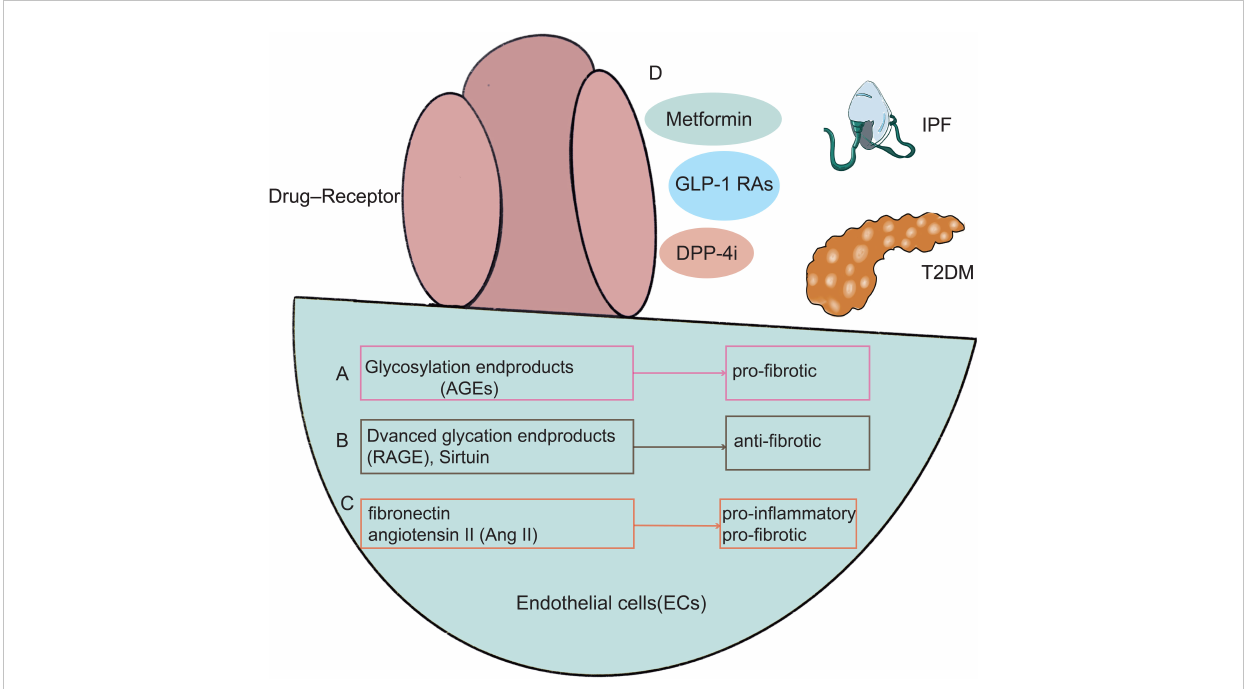
FIGURE 5 There are shared mechanisms in endothelial cell dysfunction in T2DM with IPF, with existing research focused on AGEs (A) , RAGE (B) , and Ang II (C) . In the meanwhile, diabetic therapies such as metformin, GLP-1 receptor agonists, DPP-4 inhibitors, and PPAR-agonists may alleviate pulmonary function decline by enhancing endothelial function (D) . GLP-1 RAs, GLP-1 receptor agonists; DPP-4i, Dipeptidyl peptidase 4